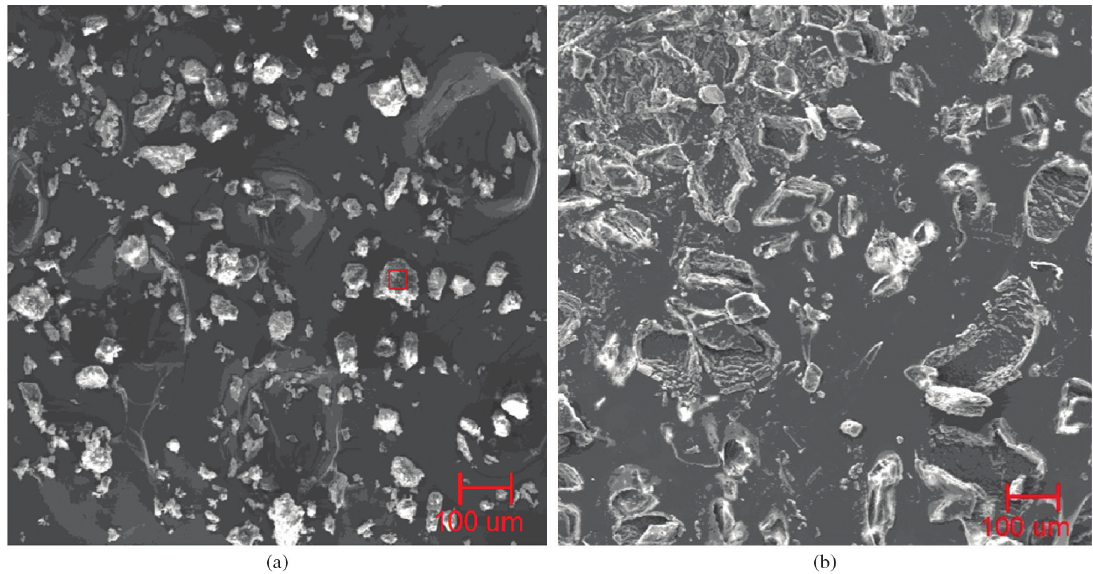
Figure 8. SEM-EDS of spectra of: a) Sodium diclofenac powder; b) Natural rubber membrane + sodium diclofenac. Notice that the diclofenac is present on